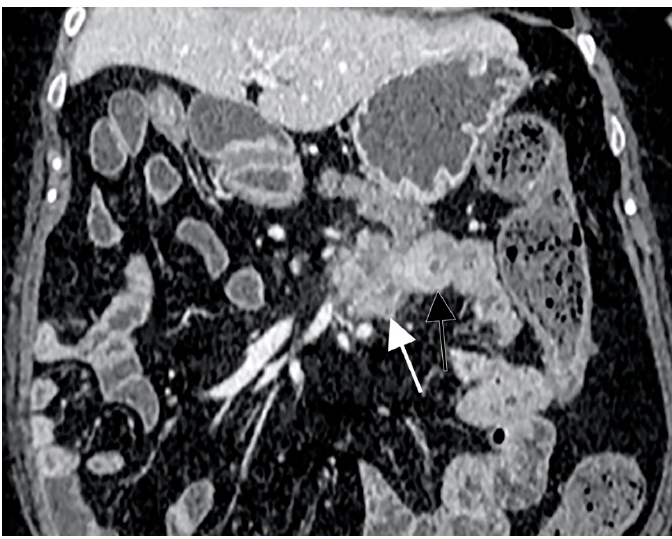
Figure 2. CT scan representation of small bowel carcinoma (SBC). White and black arrows show heterogeneous attenuation and moderate enhancement after contrast medium